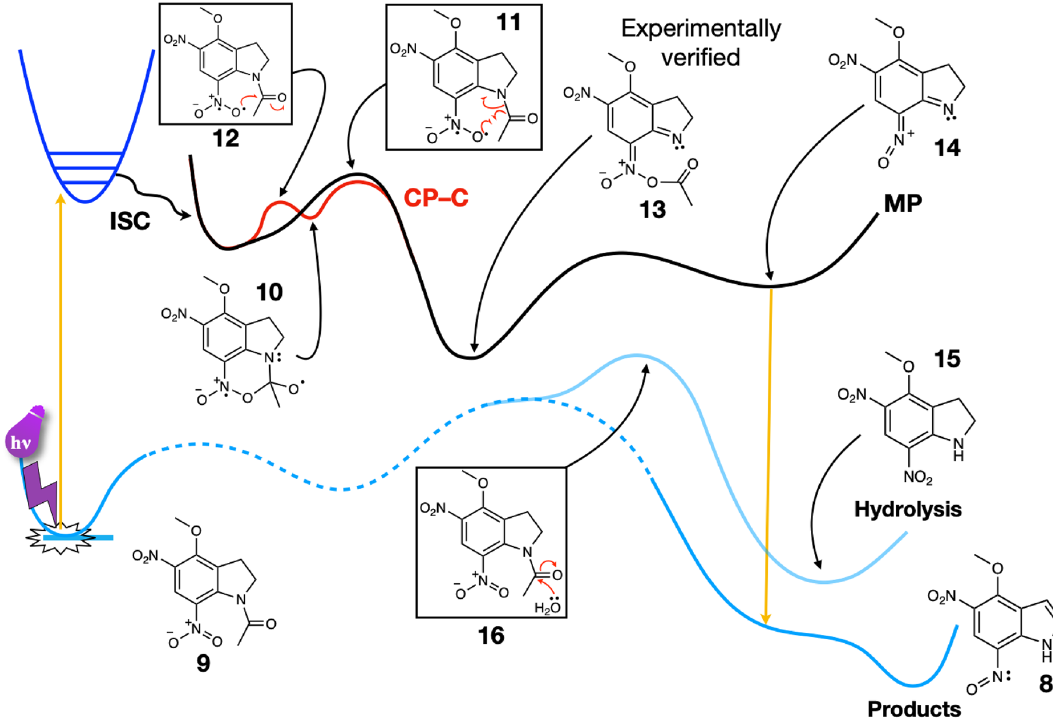
Figure 2. Schematics of the main reaction pathways for MDNI-Ac: Migration Pathway (MP)—mechanism of Pálfi et al., verified by our improved computational results; Cyclization Pathway–C (CP-C) mechanism via cyclic intermediate (see text for a detailed explanation of the pathways). Note that both mechanisms converge towards intermediate 13 . The hydrolysis pathway on the singlet surface is also shown. The structures of the relevant transition states are reported in a box, while significant intermediates and products are reported without a